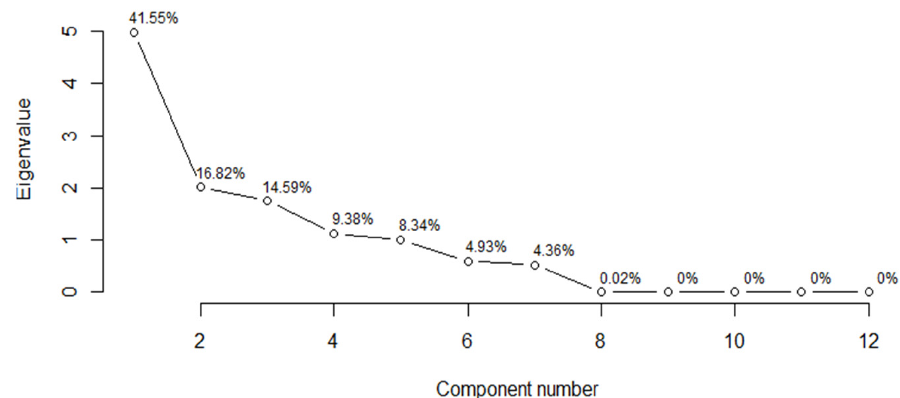
Figure 1. Scree plots of the ordered eigenvalues based on infective juveniles.